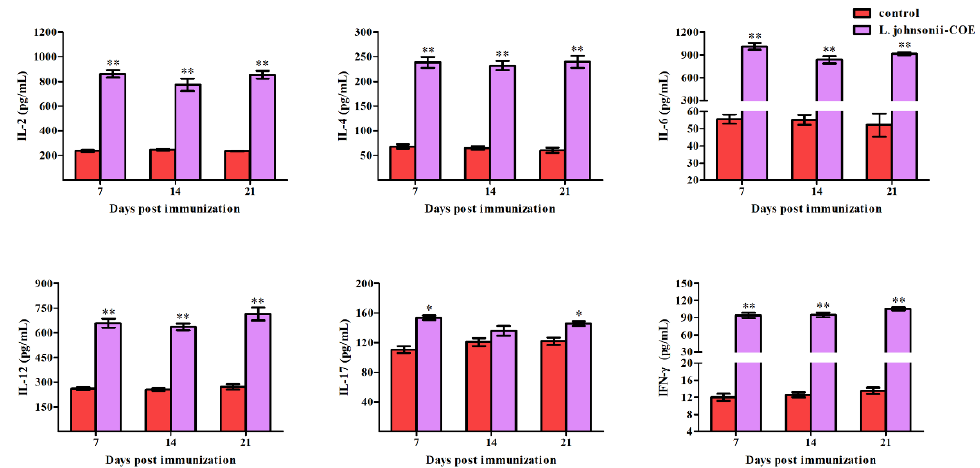
Figure 7. Levels of the cytokines in immunized sow. Cytokines including IL-2, IL-4, IL-6, IL-12, IL- 17, and IFN- γ levels in serum of sow immunized with L. johnsonii-COE , and control group with fed normally were analyzed by ELISA. * ( p < 0.05) and ** ( p < 0.01).